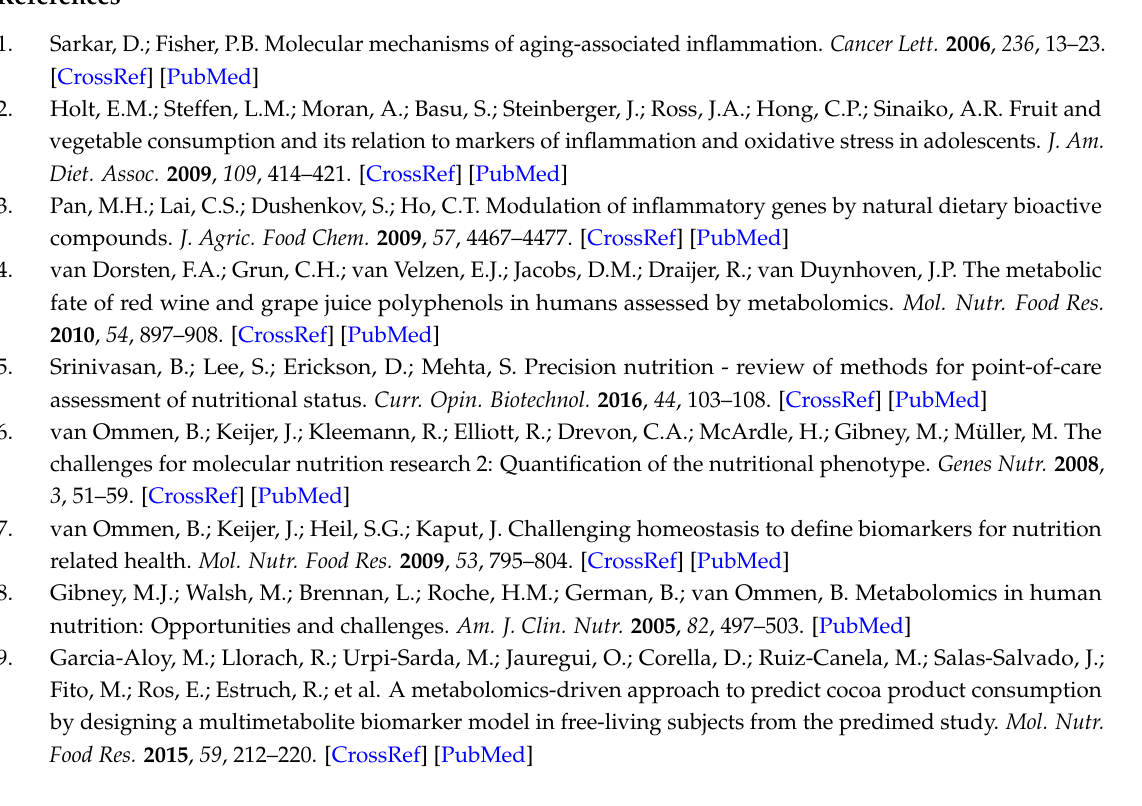
Figure S1: The Consolidated Standards of Reporting Trials flow diagram representing the phases of the randomized study for comparing the two species of raspberries, Table S1: Baseline characteristics of subjects participated in a preliminary study, Table S2: Daily dietary energy and nutrient intake at baseline and Week 4, Table S3: Comparison of anti-oxidant and anti-inflammatory effects of KBR and NAB in sedentary overweight/obese adults challenged with exercise, Table S4: Summary of urinary 1 H NMR metabolites before and after placebo or KBR administration in sedentary overweight/obese adults challenged with exercise, Table S5: Summary of plasma 1 H NMR metabolites before and after placebo or KBR administration in sedentary overweight/obese adults challenged with exercise, Table S6: Associations between the changes in traditional biomarkers and urinary metabolomic signatures at